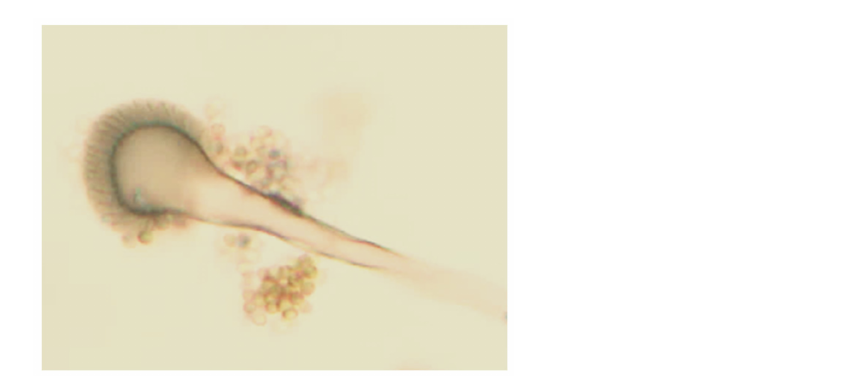
Figure 4. Microscopic morphology of Aspergillus niger viewed at 100 × . The morphology of Aspergillus niger shows large, globose, dark brown conidial heads. Conidiophores were smooth walled, hyaline, or turning dark towards the vesicle.